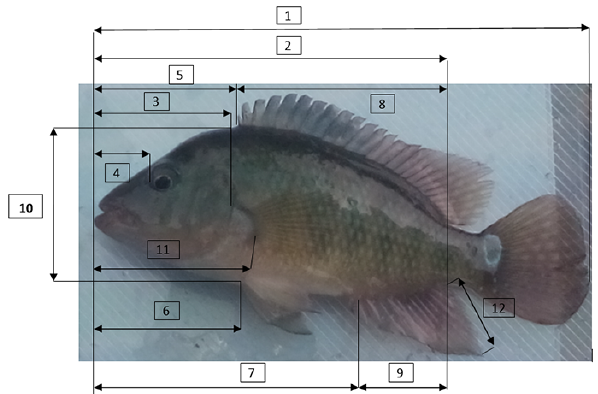
Figure 1. The morphometric measurements registered in each anal- ysed organism (source: own elaboration). 1: total length (TL); 2: standard length (SL); 3: head length (HL); 4: pre-orbital length (Pre- OL); 5: pre-dorsal length (Pre-DL); 6: pre-ventral length (Pre-VL); 7: pre-anal length (Pre-AL); 8: dorsal fin length (DFL); 9: pharyn-